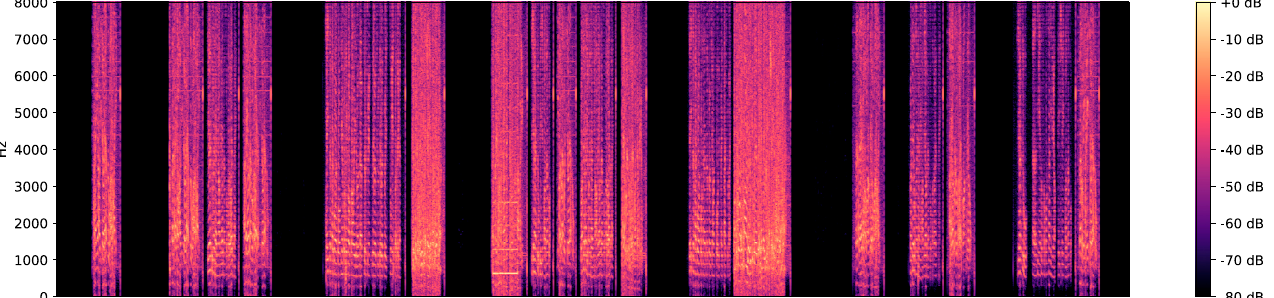
Figure 3. The volatile background noise model in a same frequency.